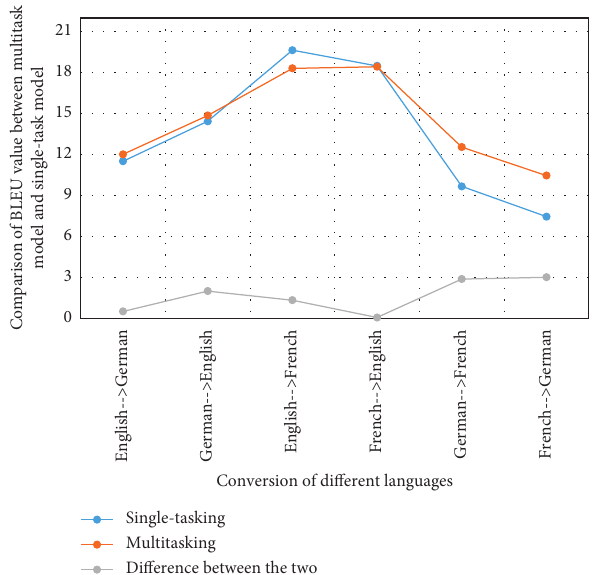
Figure 5: Performance comparison between multitask model and single-task model.